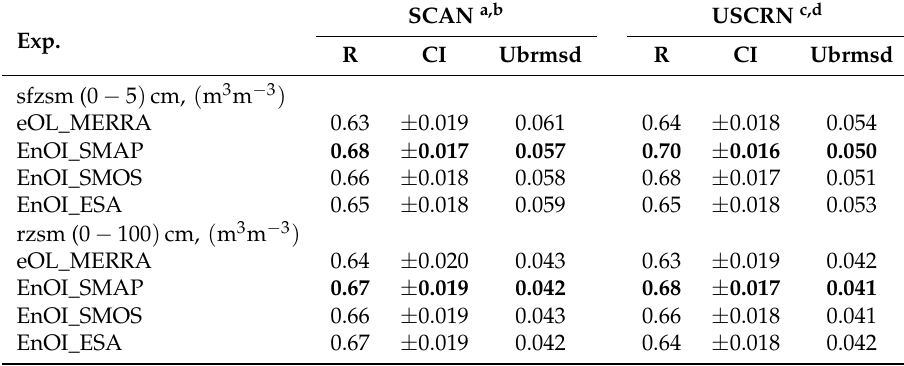
Table 4. Satellite skill metrics at SCAN and USCRN networks using MERRA-2 atmospheric forcing. The Pearson R correlation coefficient with half values of the 95% confidence interval (CI) for the individual experiments. The experiments with highest skill metrics are highlighted in